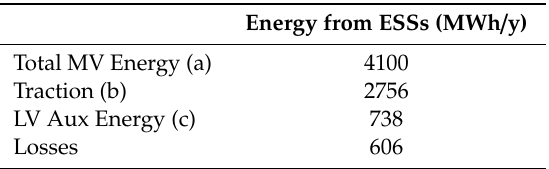
Table 4. Annual energy